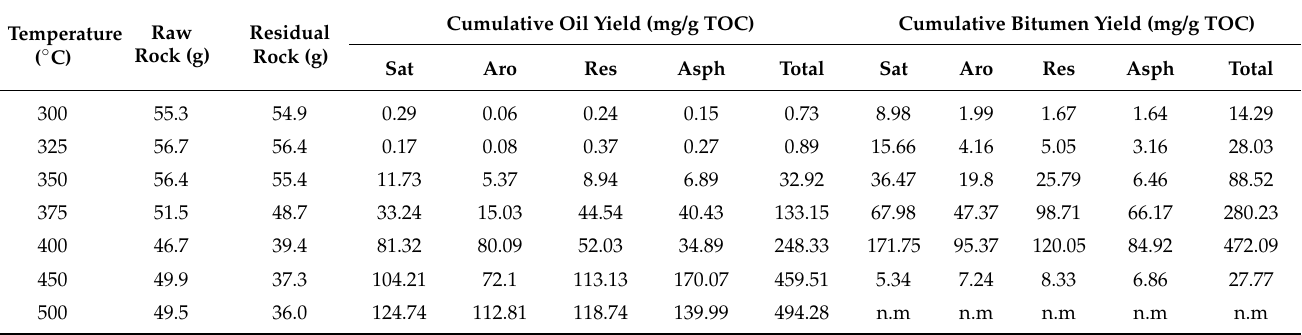
Table 3. Product yields (residual rock, oil, and bitumen) of the thermal simulation experiment.